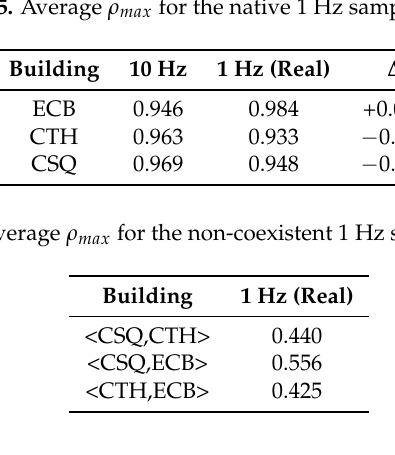
Table 5. Average ρ max for the native 1 Hz sampled traces.